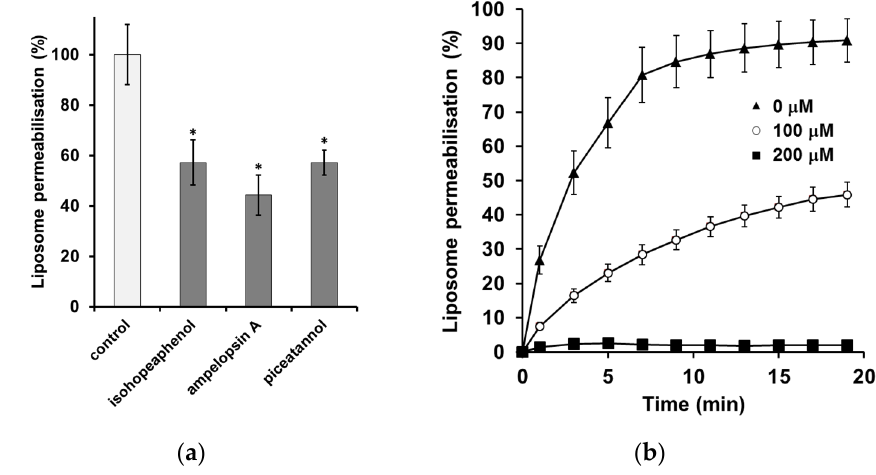
Figure 5. Effect of incubation with stilbenes on α -synuclein-induced content leakage from phosphatidyl inositol LUVs: ( a ) Stilbenes were each incubated at 100 µ M with α synuclein. Leakage is expressed as a percentage of the effect induced by the addition of α synuclein aggregated alone; ( b ) α -synuclein was incubated with 0 µ M, 100 µ M, or 200 µ M of piceatannol. Leakage was recorded for 20 min, and results are expressed as a percentage of total calcein leak induced by the addition of Triton X-100. The phospholipidic solution was 20 µ M. α -synuclein was aggregated at 70 µ M alone or with stilbenes for 6 days at 37 ˝ C in a 20 mM Na 2 HPO 4 /NaH 2 PO 4 140 mM Tris buffer, pH 7.4 prior to the experiment. Data are expressed as mean ± SD of 3 independent experiments. * p < 0.05 versus control alone.